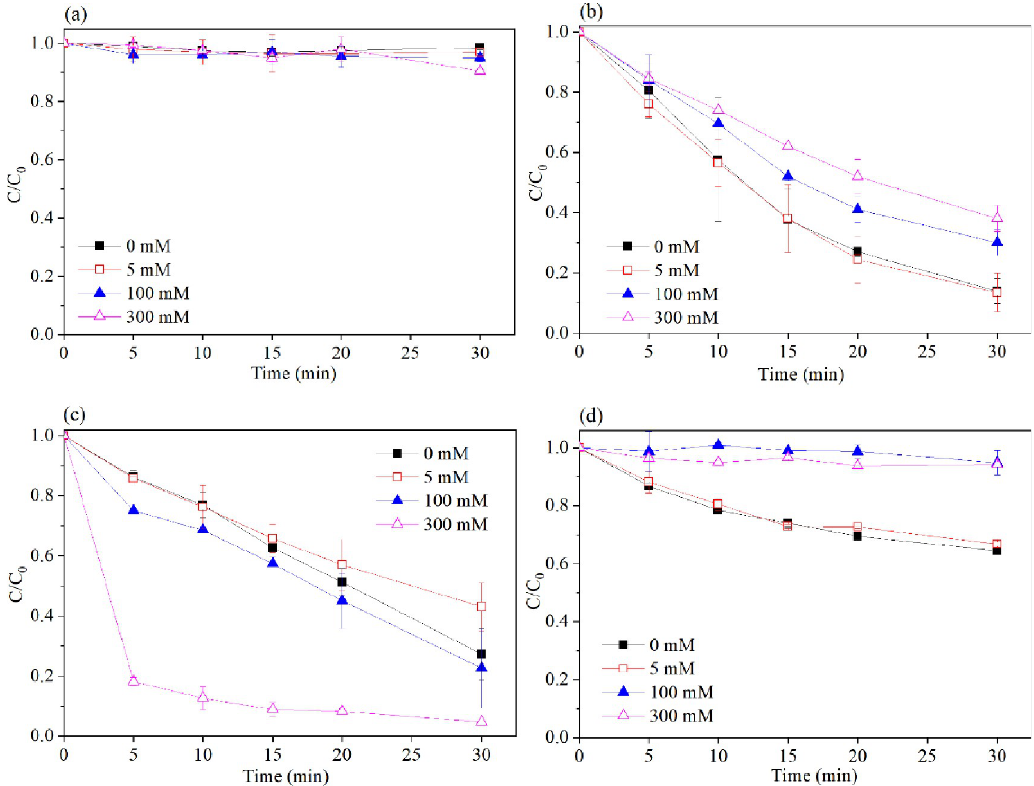
Fig 5. Effect of chloride ions concentration on the degradation of 2,4,6-TCP in four systems. (a) Fe 0 ; (b) Fe 0 /H 2 O 2 ; (c) Fe 0 / PMS; (d) Fe 0 /PS. Conditions: c(2,4,6-TCP) = 0.2 mmol•L -1 ; c(Ox) = 1 mmol•L -1 ; c(Fe 0 ) = 0.1 g/L; pH = 3.2 ± 0.05.